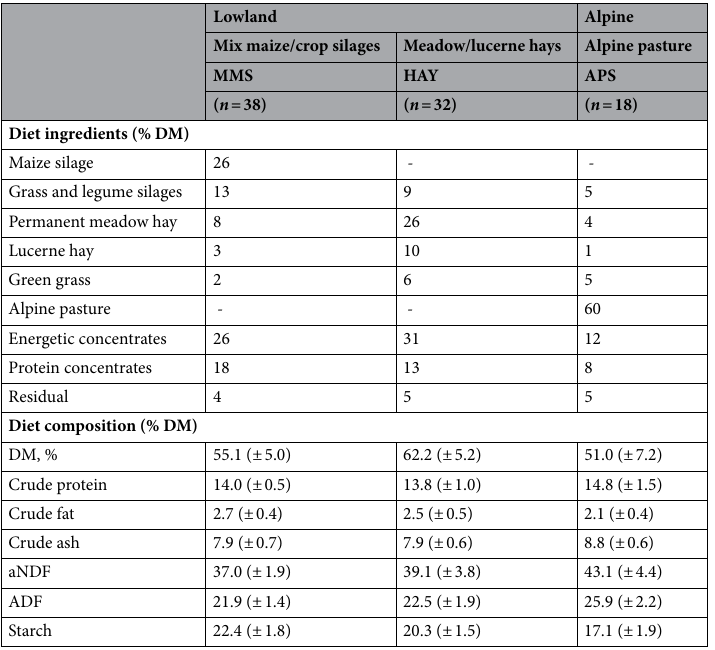
Table 1. Diet formulation and proximate composition (average ± standard deviation) of the feeding groups based on the main forage source (% on dry matter, DM). Energetic concentrates , maize and barley grain derivates (meal, extruded, rolled, flaked); protein concentrates , soybean and sunflower products; residual , straw, bran, beet pulps, mineral-vitamin premix; aNDF , neutral detergent fibre; ADF , acid detergent fibre. For APS, data referred to the grazing period and considered a theoretical daily dry matter intake (kg) per lactating cow of 12, 5 and 3 of pasture, energetic and protein concentrates and a mix of dried and ensiled forages,